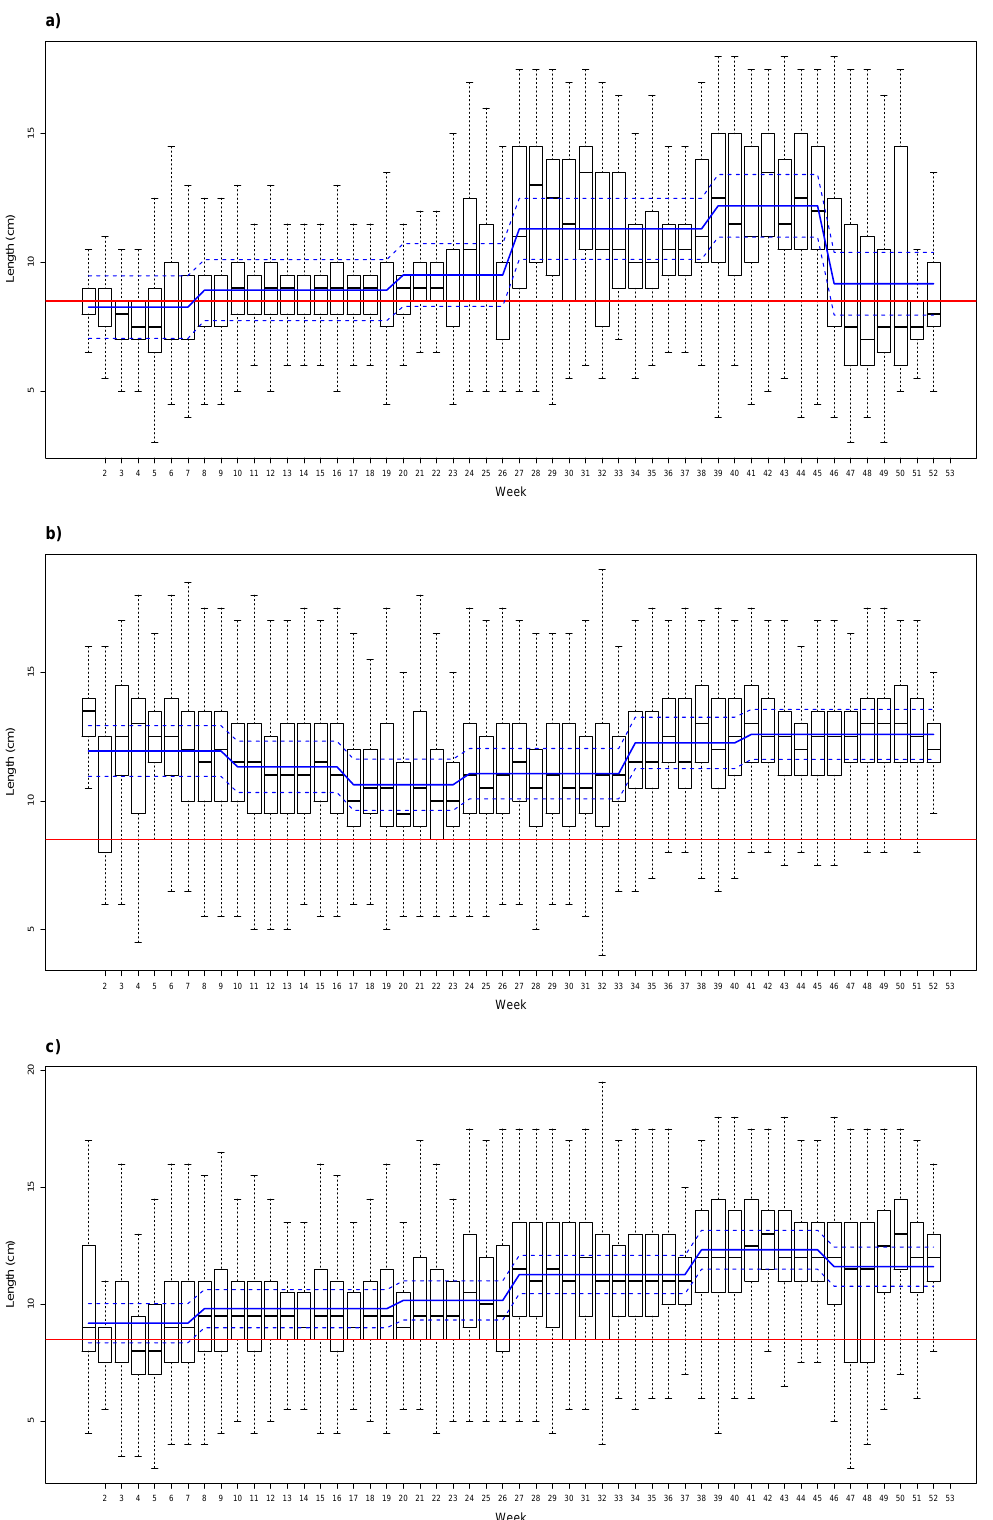
Figure 3. Weekly means of length (cm) and 5-break model adjustment incorporating 95% confidence bands for adjustment for common sardine of ( a ) V.–VIII., ( b ) IX.–XIV., and ( c ) V.–XIV. Regions and period